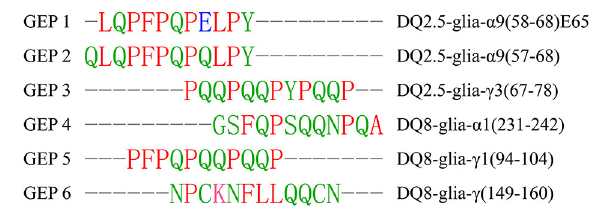
FIGURE 1 | Sequence alignment of the selected gluten epitope peptides (GEPs). The six selected GEPs were chosen among the reported gluten epitopes with maximum primary sequence diversity, and aligned with the European Bioinformatics Institute of the European Molecular Biology Laboratory (EMBL-EBI) multiple sequence alignment tool for sequence comparison. The leftmost lane is the number of the GEP, the middle is its sequence, and the rightmost lane is the number of the amino acid residues in each corresponding GEP. The rightmost lane is the epitope with the most similar amino acid sequences. Red indicates amino acid residues L, P, F, and A; green indicates amino acid residues Q, Y, G, S, N, and C; blue indicates amino acid residue E; magenta indicates amino acid residue